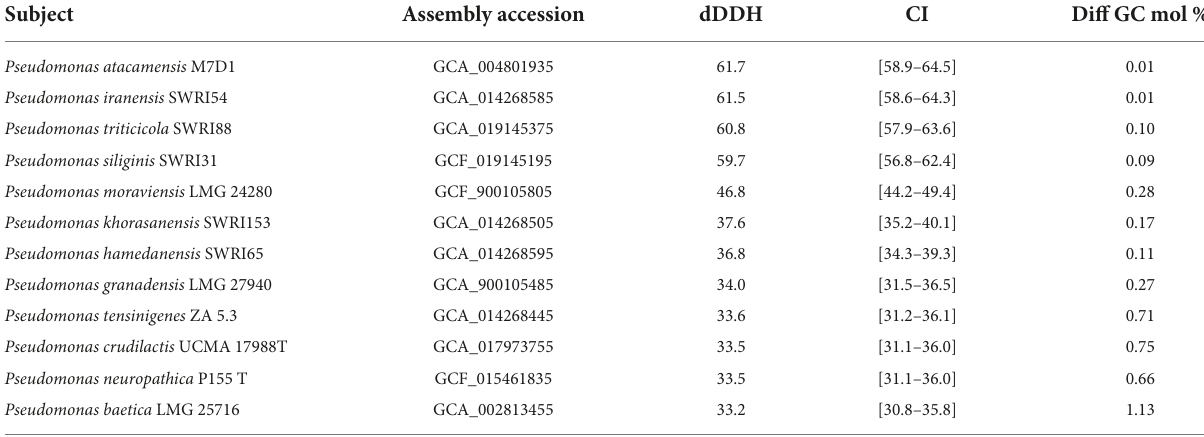
TABLE 2 DNA-DNA hybridization in silico (dDDH), confidence interval (CI), and GC percentage difference between SAICEUPSM T and Pseudomonas spp. closely related.